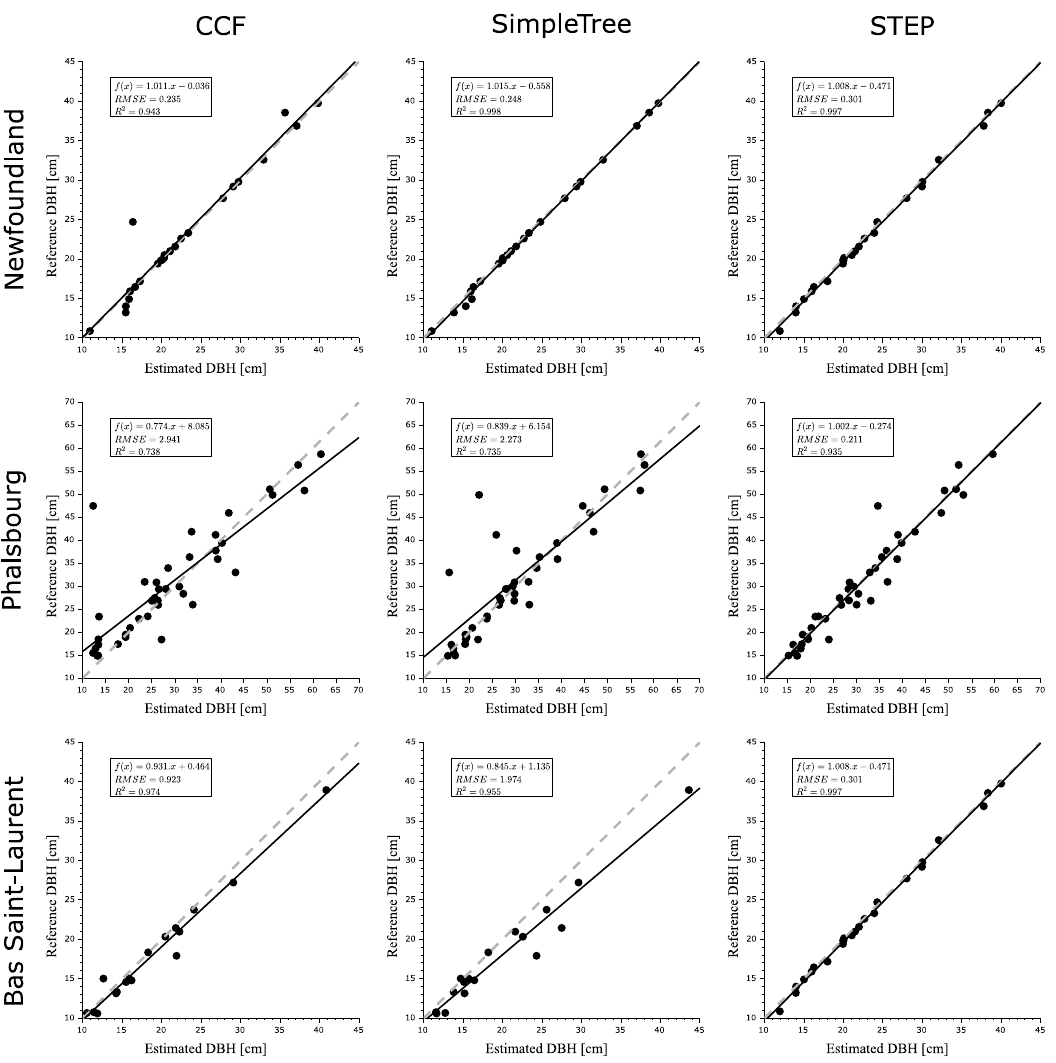
Figure 6. Diameter at breast height (DBH) estimation error using the three selected algorithms for each site. The grey dotted line is the 1:1 line.